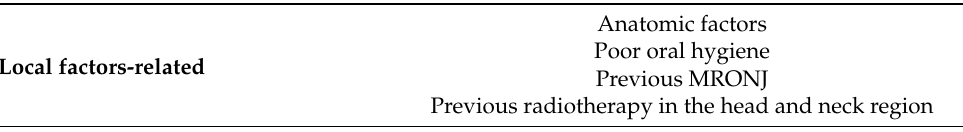
Table 3. Medication-related osteonecrosis of the jaw (MRONJ) risk factors and predisposing